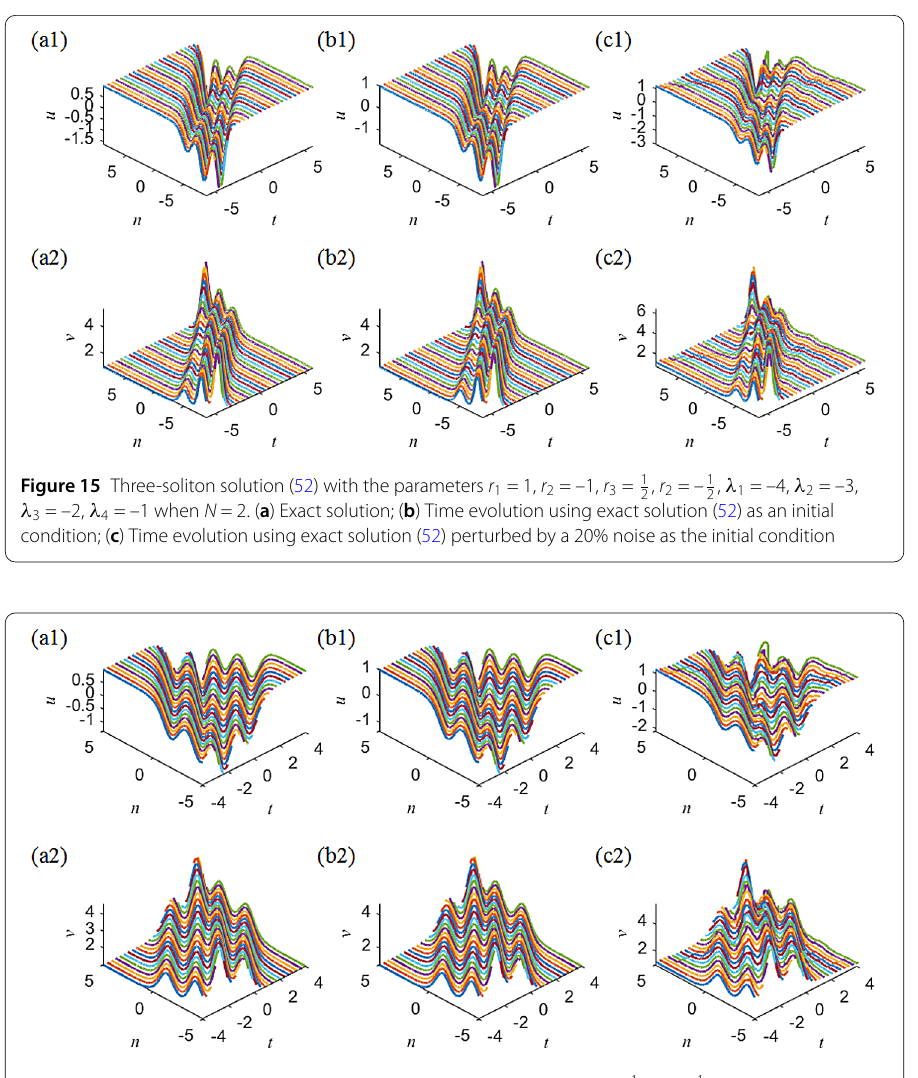
, r 2 = – 1 , λ 1 = –4, λ 2 = –3, 2 2